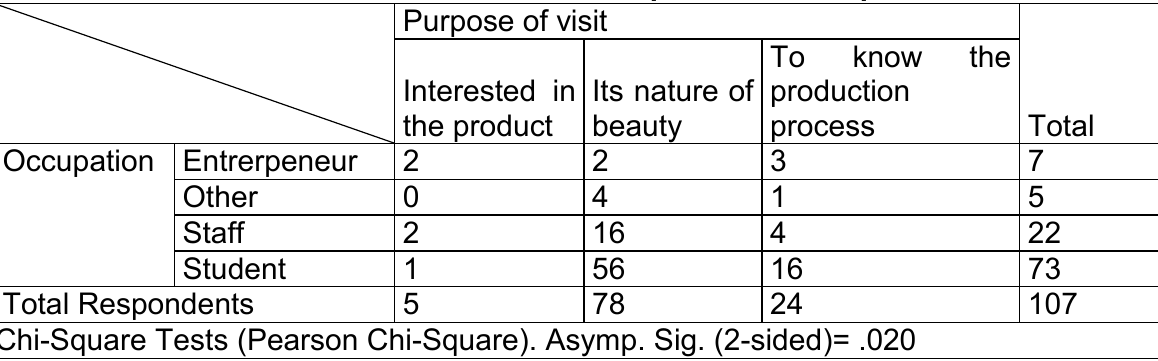
Table 3 The Correlation between Tourist Occupation and Purpose of Visit to